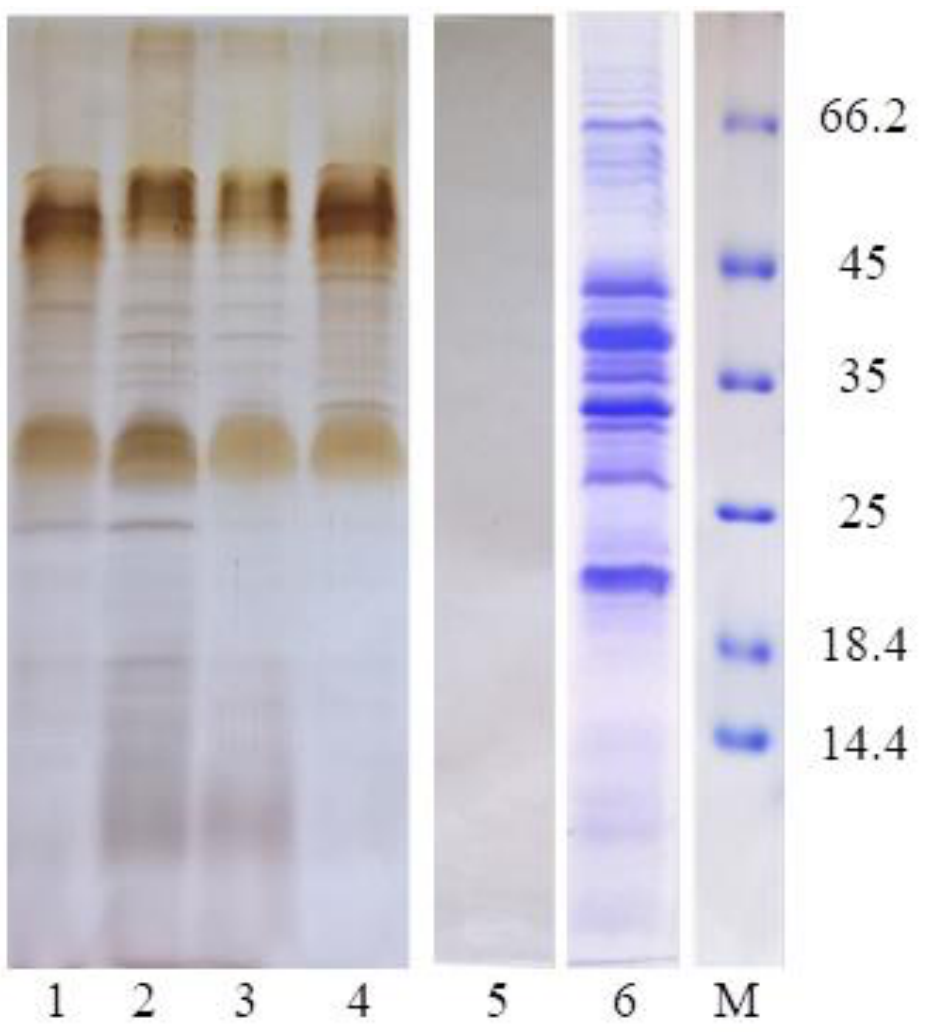
Figure 5. SDS–PAGE, followed by staining with AgNO 3 -based dye (lanes 1–4) and Coomassie brilliant blue (lanes 5, 6, M) of the following samples: LPS (lane 1), deproteinated BM (lane 2) and native crude BM (lanes 3, 6), as well as BM3 (lanes 4, 5). Lane M represents protein markers (with their corresponding molecular masses in kDa).